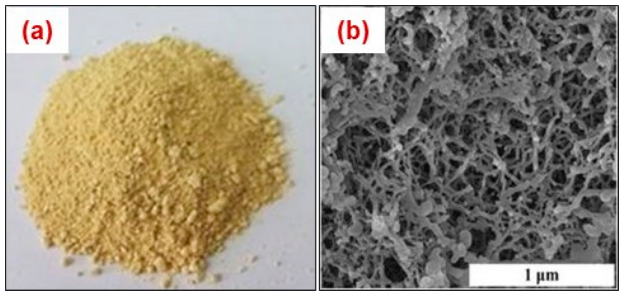
Figure 11. Photograph ( a ) and SEM image ( b ) of PI aerogel powders obtained from the imidization of PMDA/4,4 ′ -MDA-derived PAA. Adapted by permission from Springer Nature Customer Service Centre GmbH: Ref. [98].